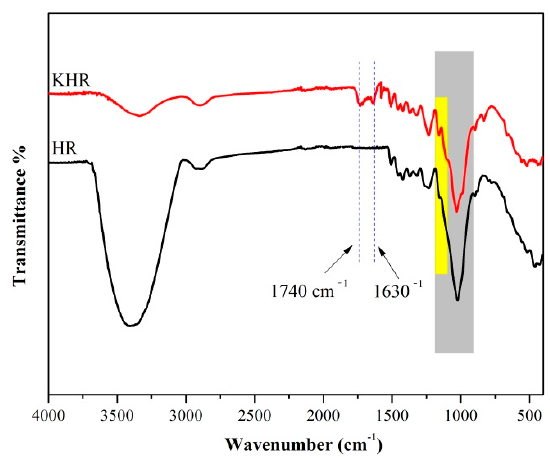
Figure 1. The FTIR spectra of the HR and KHR.